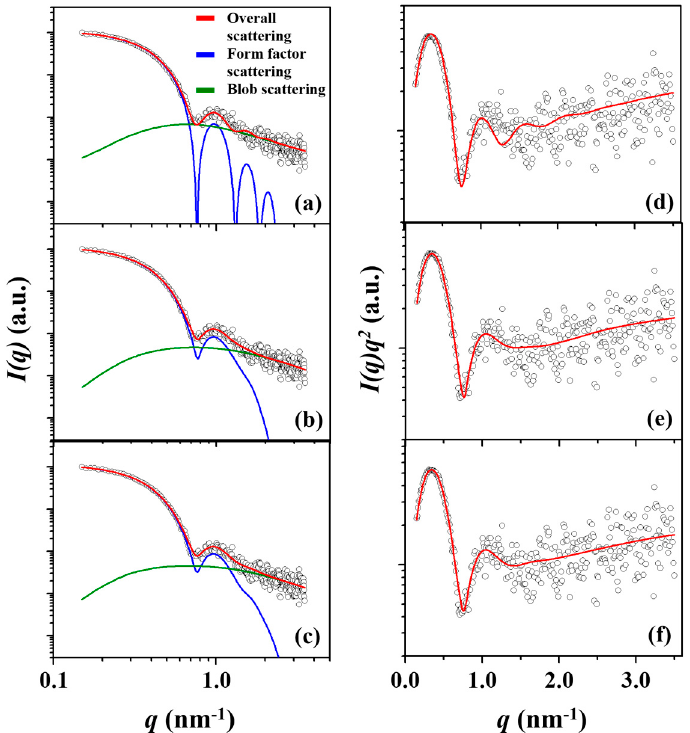
Figure 5. A representative X-ray scattering intensity I ( q ) profile and data analysis results of the c -PBA- b -PEO micelle formed in deionized water with a concentration of 0.5 wt % at 25 ◦ C, which were performed using ( a ) spherical CFS model, ( b ) two phase ellipsoid model, and ( c ) three phase ellipsoid model. ( d – f ) Kratky representations of the scattering data of the l -PBA- b -PEO micelle fitted by spherical CFS, two phase ellipsoid, and three phase ellipsoid models, respectively. In each figure, the open dot symbols are the measured data and the red solid line represents the sum of the corresponding analysis profile (blue line) and blob contribution (green line). q = (4 π / λ )sin θ in which 2 θ is the scattering angle and λ is the wavelength of the X-ray beam used. Table 4. Structural parameters of the c -PBA- b -PEO micelle obtained from the quantitative analysis of scattering data with various model approaches.